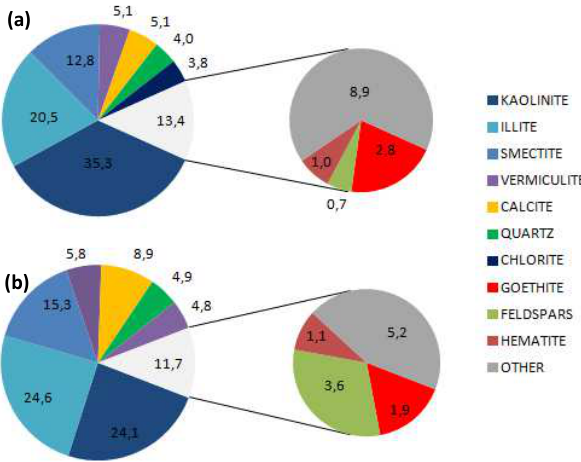
Fig. 8. Average mineralogical composition of the major dust-source regions (clay fraction, CASE 0). Top panel: the three major clay minerals with content higher than 5%; middle panel: calcite and quartz with contents ca. 5%; and bottom panel: minerals which con- tribute less than 4% of the mass: iron oxides and feldspars.